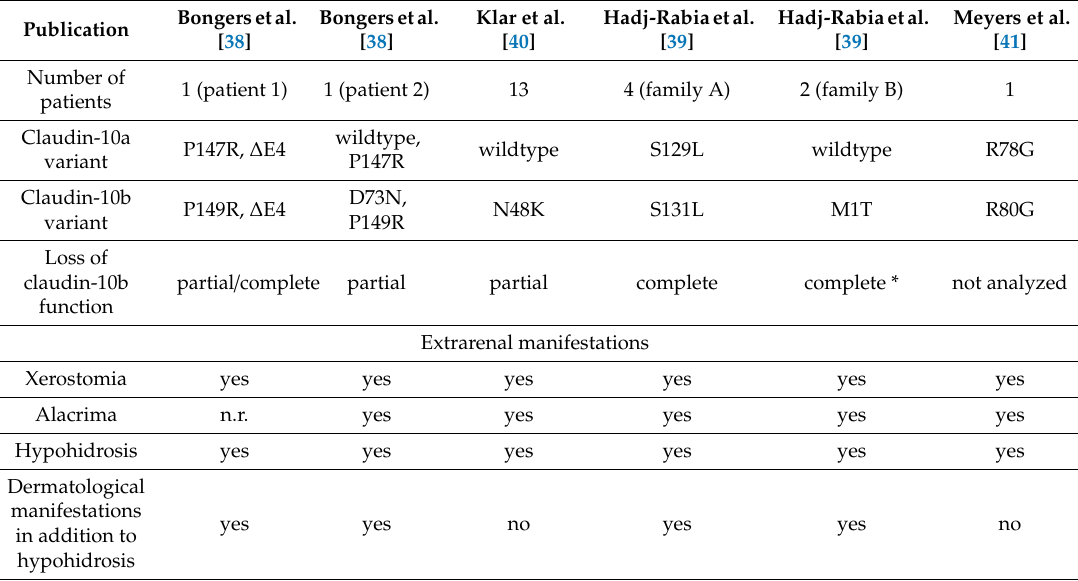
Table 1. Summary of all patient groups, their CLDN10 variants and clinical